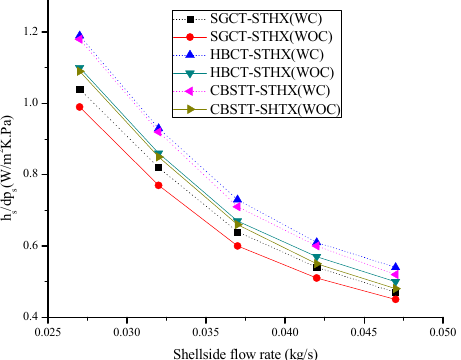
Figure 13. Heat transfer coefficient per pressure drop versus mass flow rate.